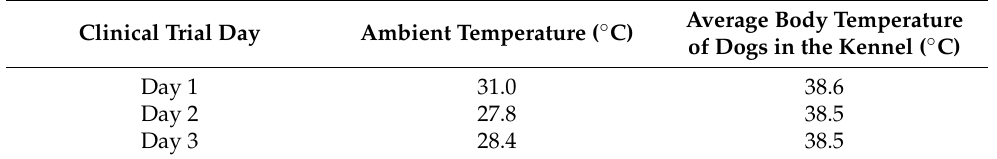
Table 3. Ambient temperature and body temperature of the dogs in kennel for each day of the trial test.